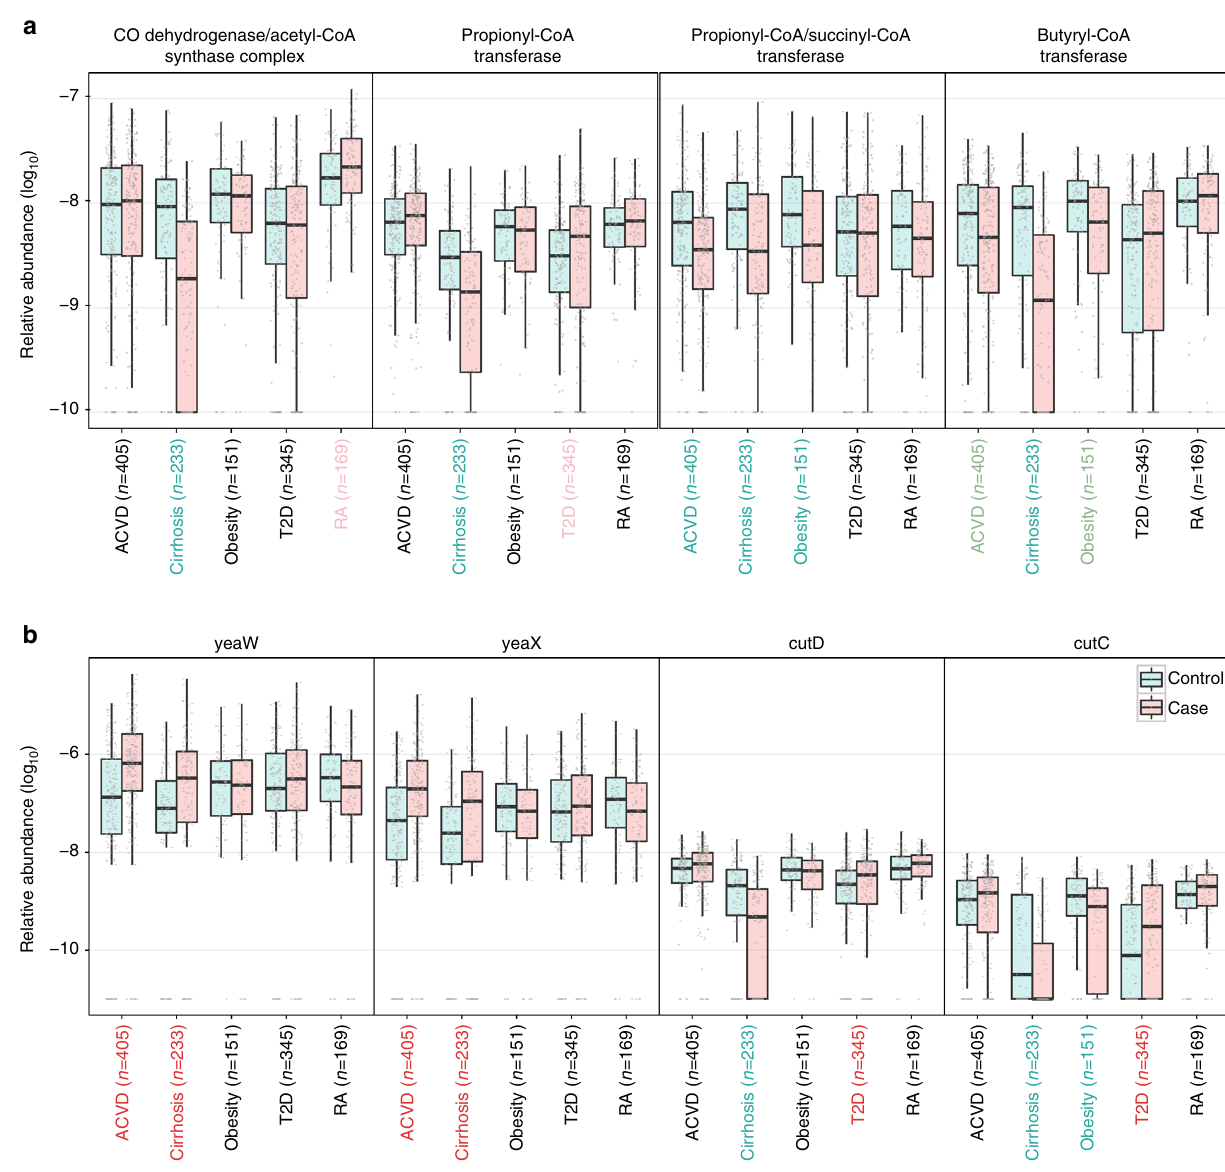
Fig. 8 Abundance differences in speci fi c gut microbial KOs in ACVD and other diseases. a Enzymes for production of SCFAs. b Enzymes for TMA production. CutD is an activator for CutC. The cohort names were colored according to the direction of enrichment, i.e. green and red for control- and case-enriched, respectively within each disease cohort (ACVD, total n = 405 including 218 cases; Cirrhosis, total n = 231 including 120 cases; Obesity, total n = 151 including 72 cases; T2D, total n = 345 including 171 cases; RA, total n = 169 including 95 cases). Wilcoxon rank-sum test, P -value < 0.01; light green and light red , Wilcoxon rank-sum test 0.01 ≤ P -value < 0.05; black, P -value ≥ 0.05. Boxes represent the median and interquartile ranges (IQRs) between the fi rst and third quartiles; whiskers represent the lowest or highest values within 1.5 times IQR from the fi rst or third quartiles. Circles represent all data